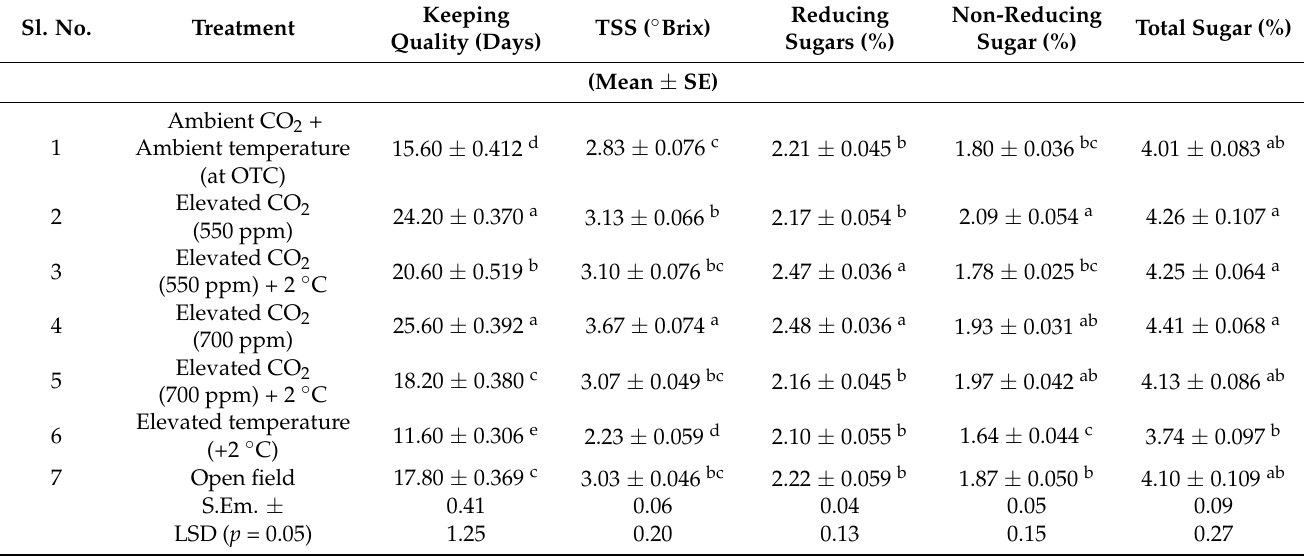
Table 3. Quality parameters of tomato as influenced by elevated atmospheric CO 2 and temperature levels. Sl.